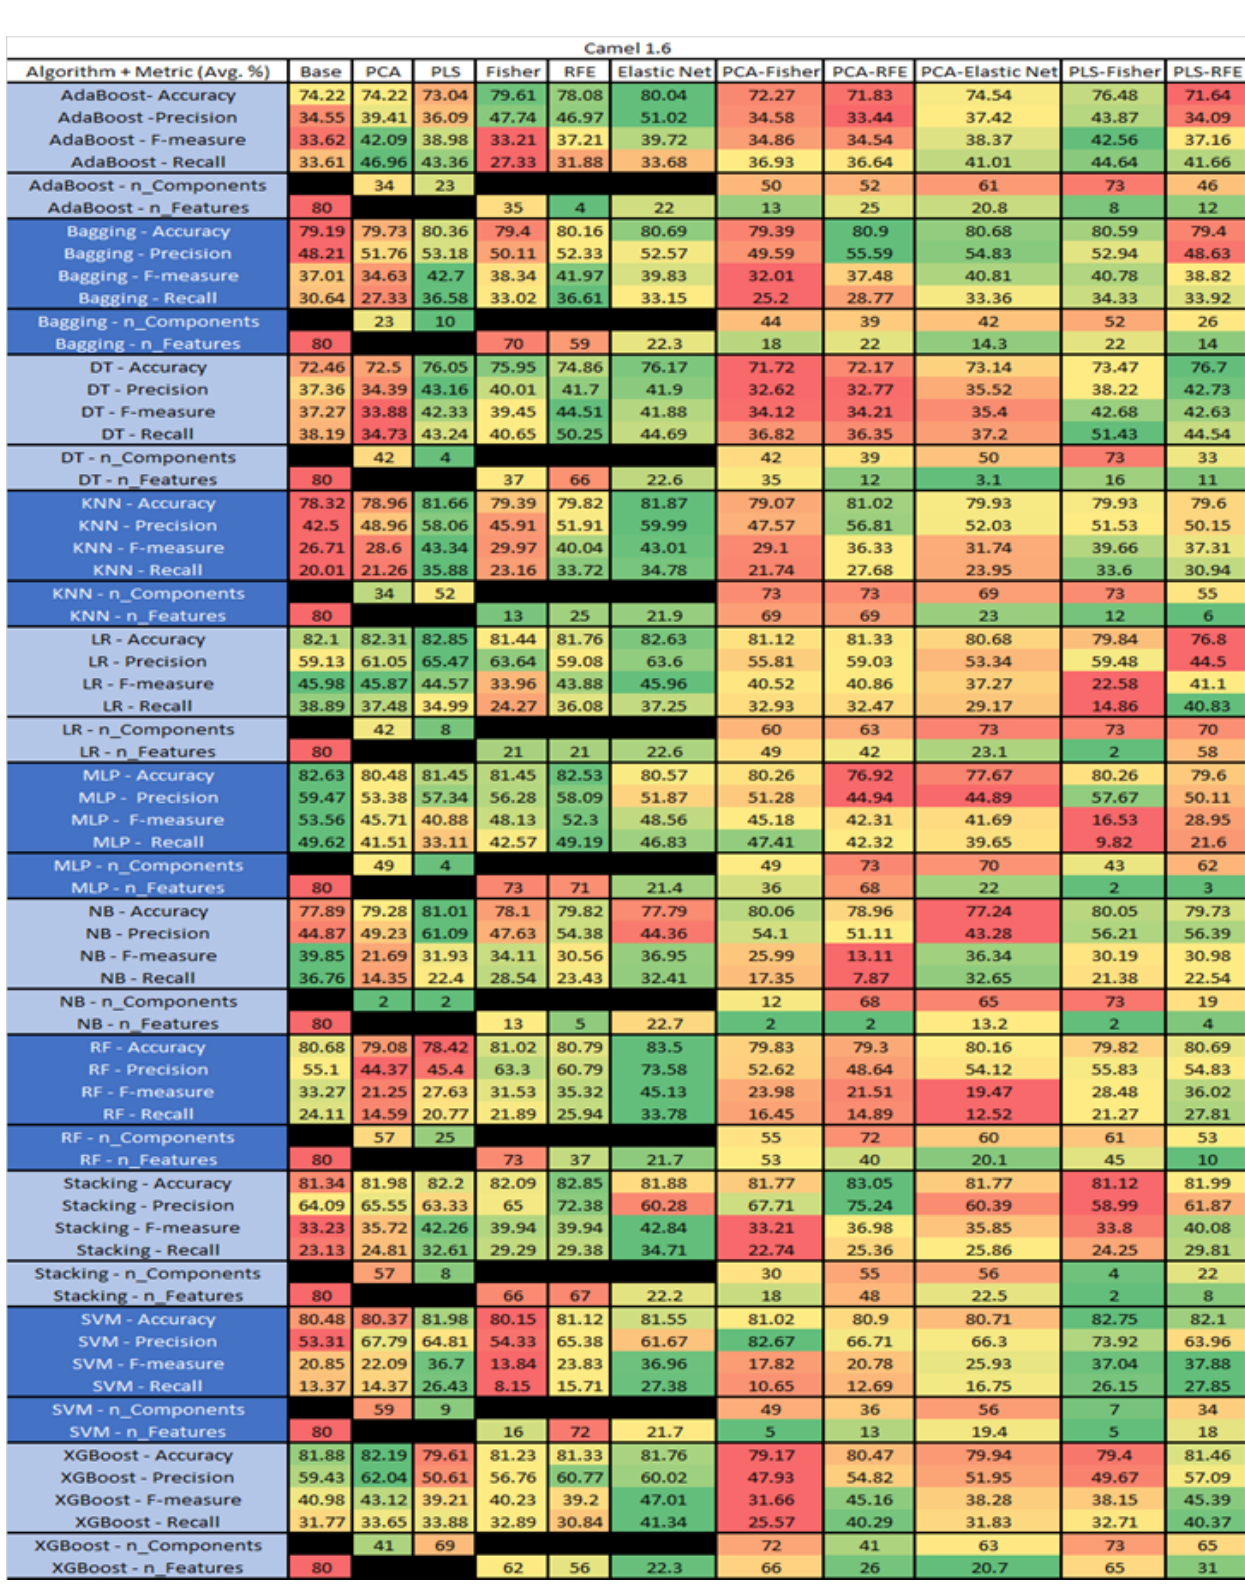
Figure 16. Camel 1.6 PROMISE Results Data